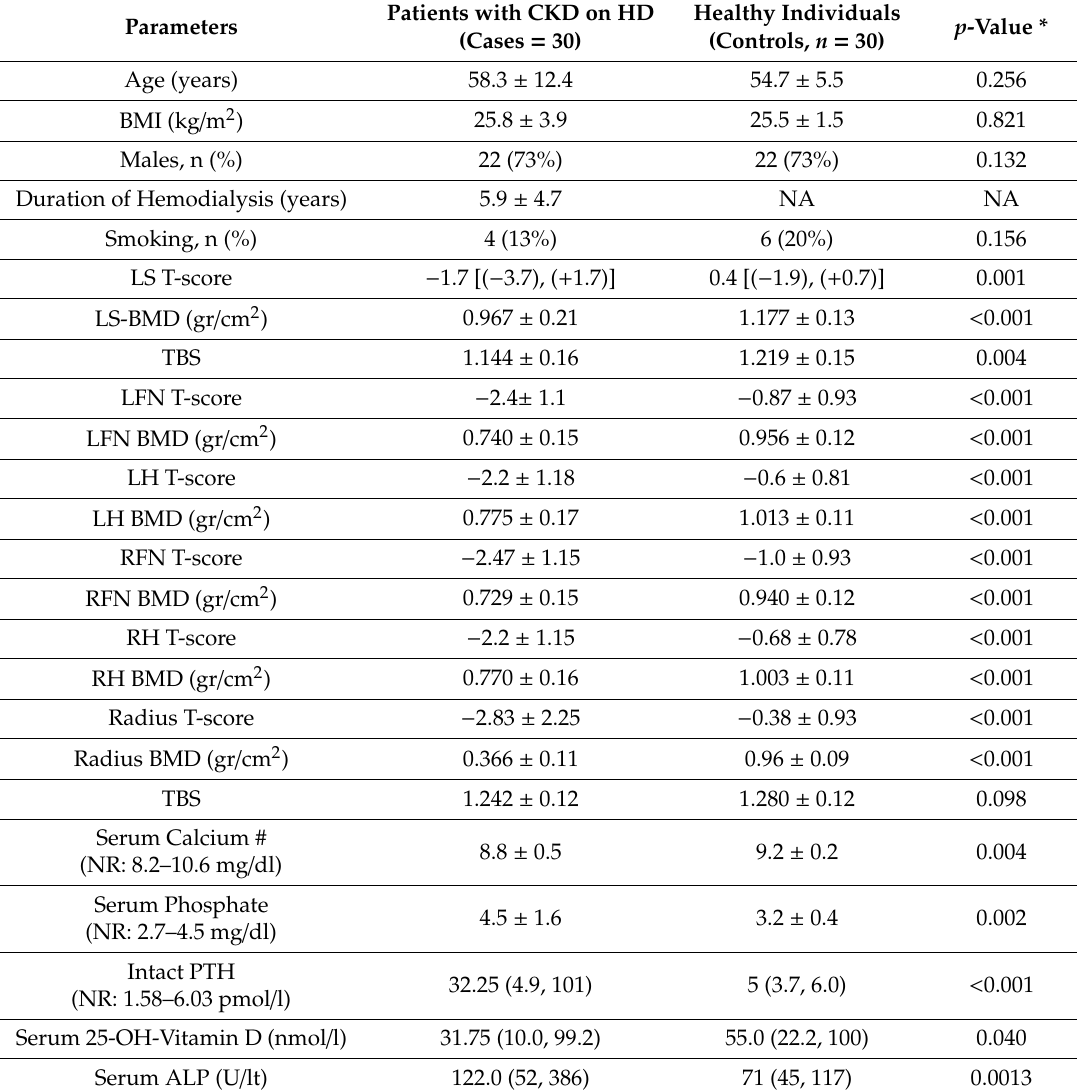
Table 2. Anthropometric characteristics and biochemical values of the study group. Patients with CKD on HD Parameters (Cases =